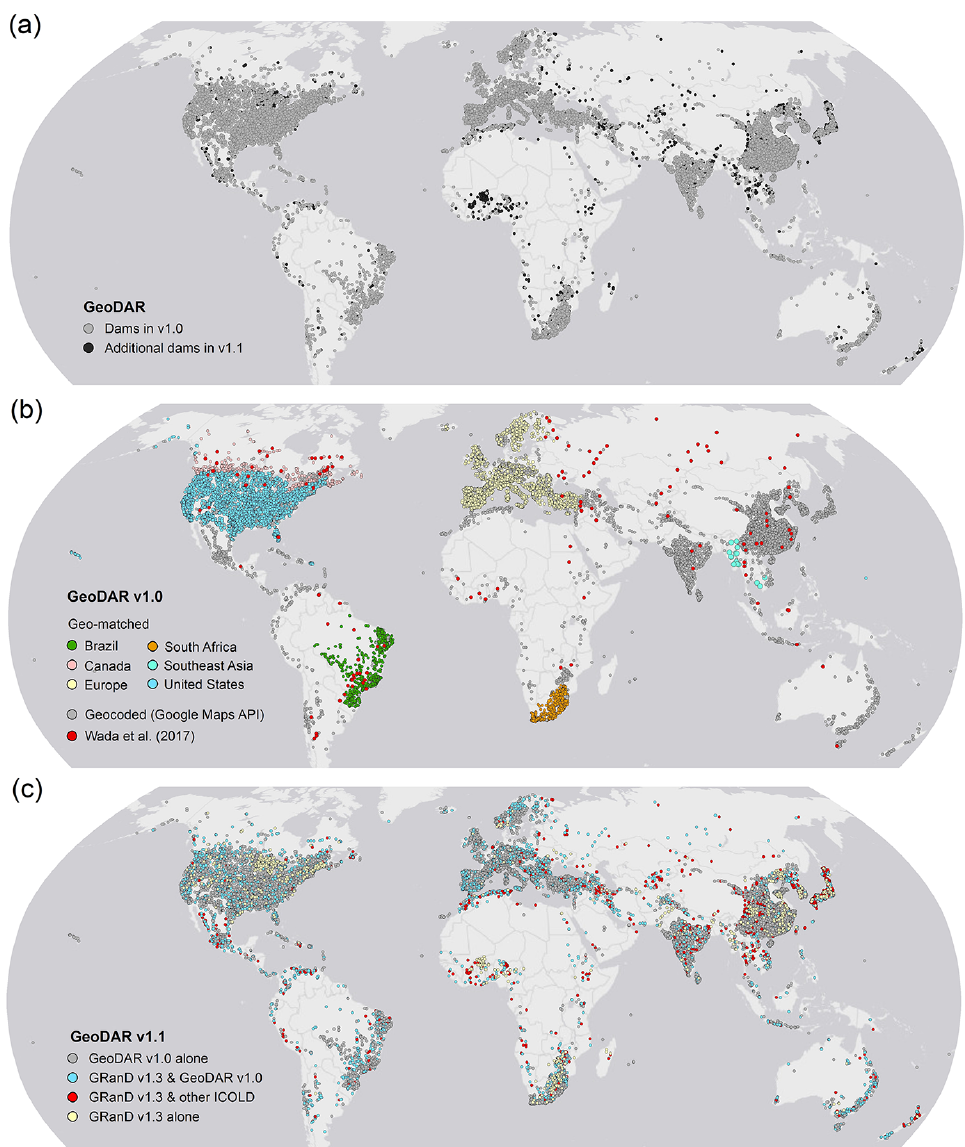
Figure 6. Georeferenced dam points in GeoDAR. (a) A total of 24783 dam points in v1.1 superimposed by 22560 dam points by in v1.0. (b) Georeferencing methods and data sources for v1.0. (c) Data sources for